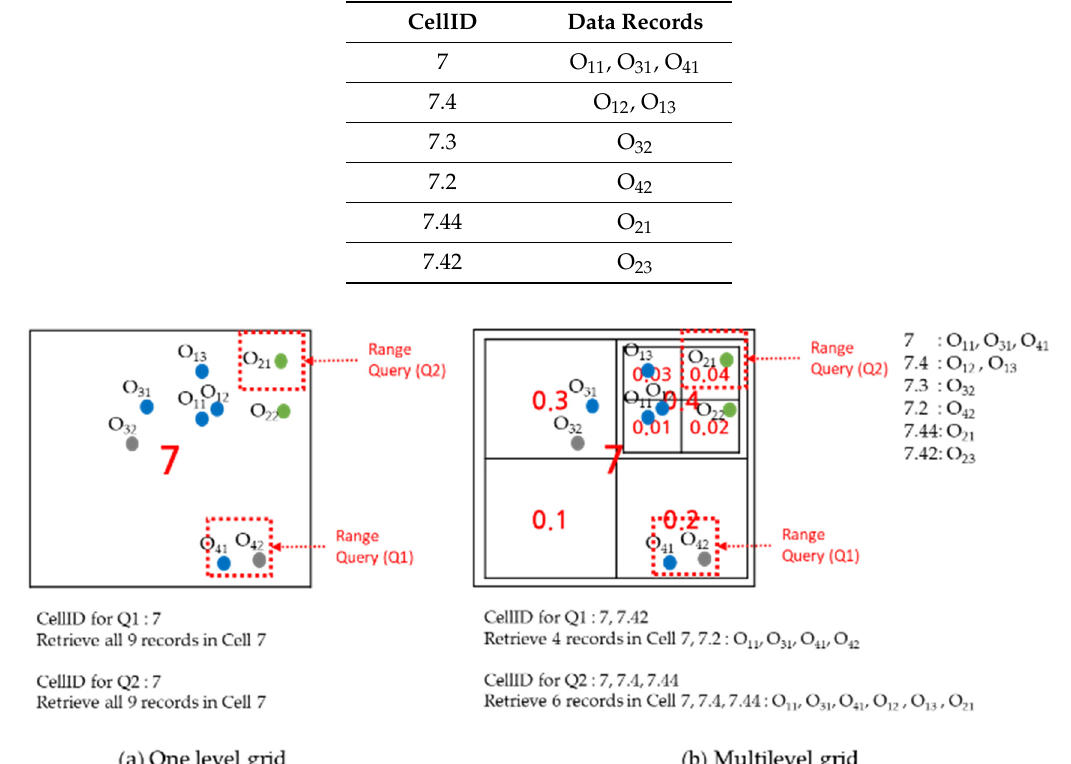
Table 1. CellIDs for data objects.